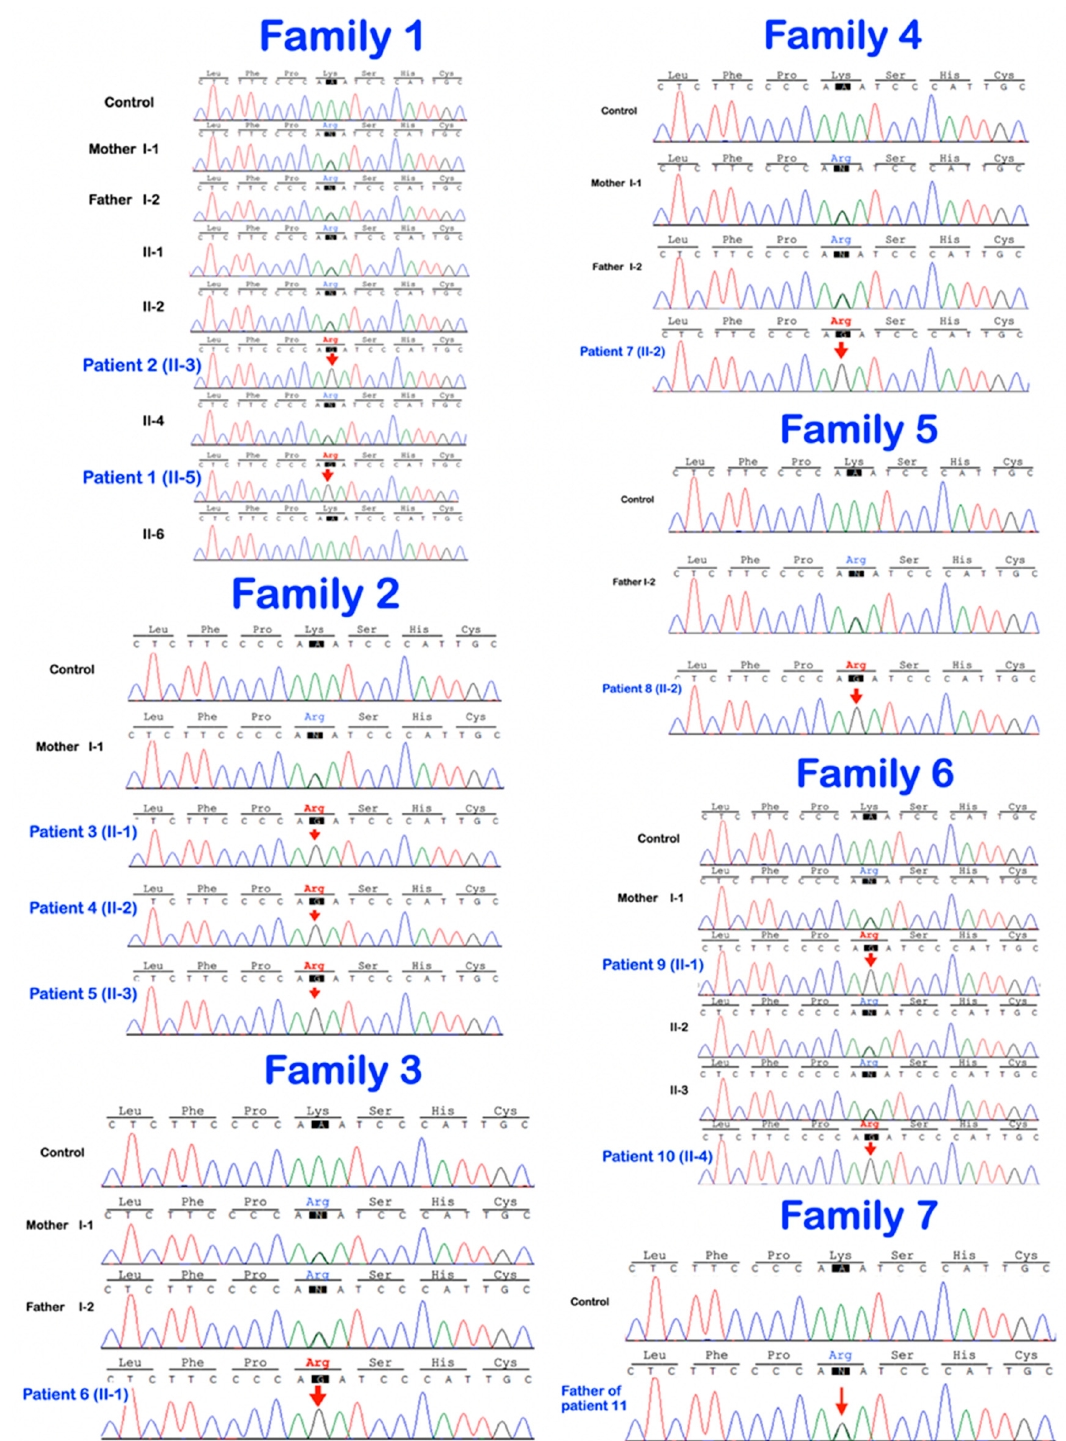
Figure 8. Sequence chromatograms show the homozygous and heterozygous base substitution (chr1:43212857A > G; NM_022356.4: c.2055 + 86A > G) in the P3H1 gene. The patients are